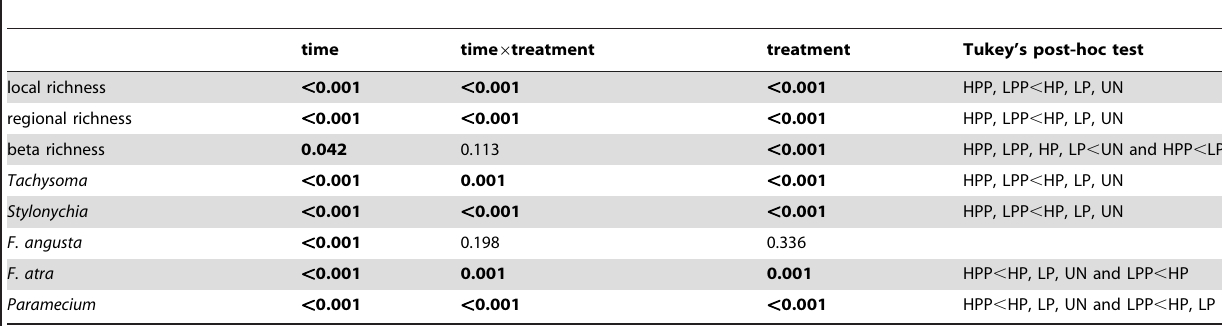
Table 1. P-values and results of Tukey’s post-hoc tests of one-way rm-ANOVAs testing for treatment effects on local, regional, and beta richness and on the abundances of the five ciliate